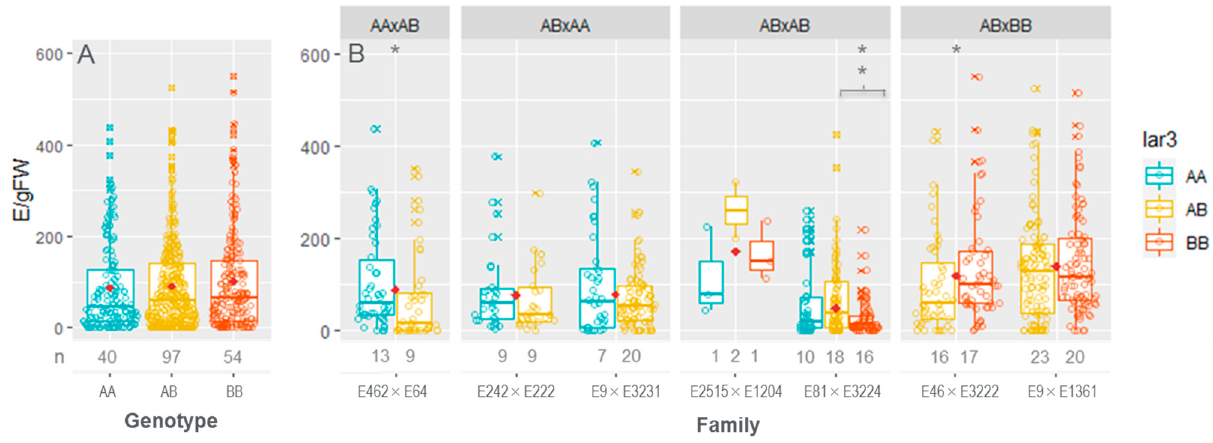
Figure 2. Embryo production capacity (embryos per gram fresh weight; E/gFW) of different PaLAR3 genotypes ( A ) of seven Norway spruce full-sib SE-families ( B ), with the number of SE lines given for each allelic combination ( n ). Asterisks denote differences between genotypes within each family (* p < 0.05, ** p < 0.01).